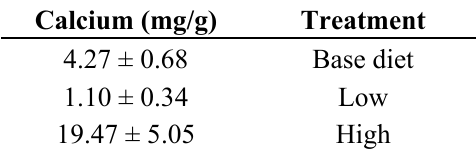
Table 1. Average (± SE) calcium concentration in shrew diets as compared to the base diet. Averages are based on three independent preparations of food made during the